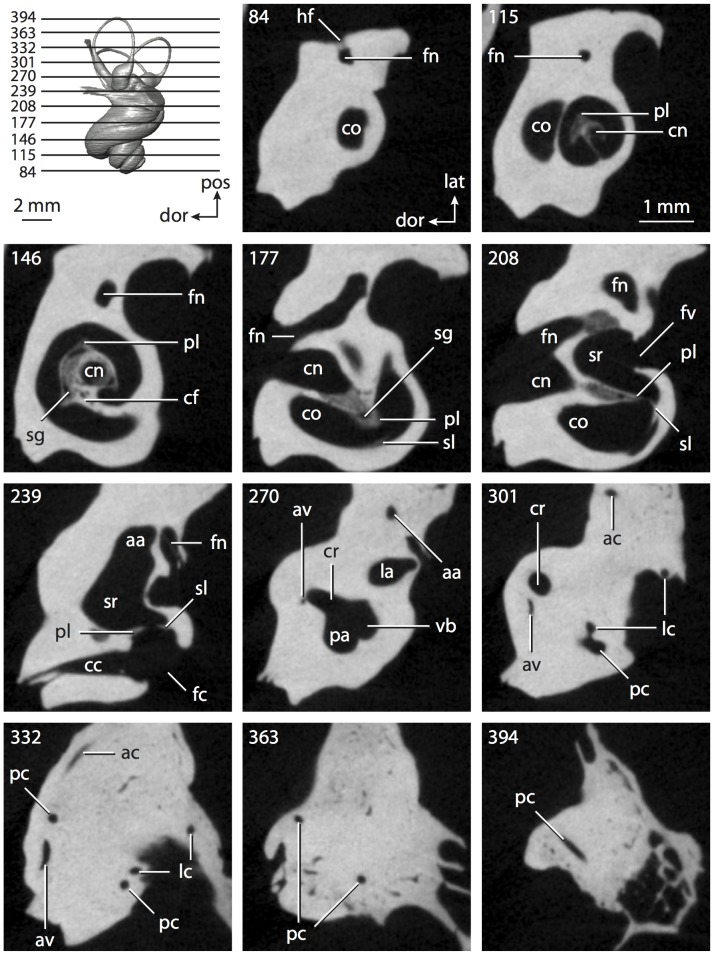
CT slices through ear region ofFelis catus.Abbreviations listed at the end of the Materials and Methods section.